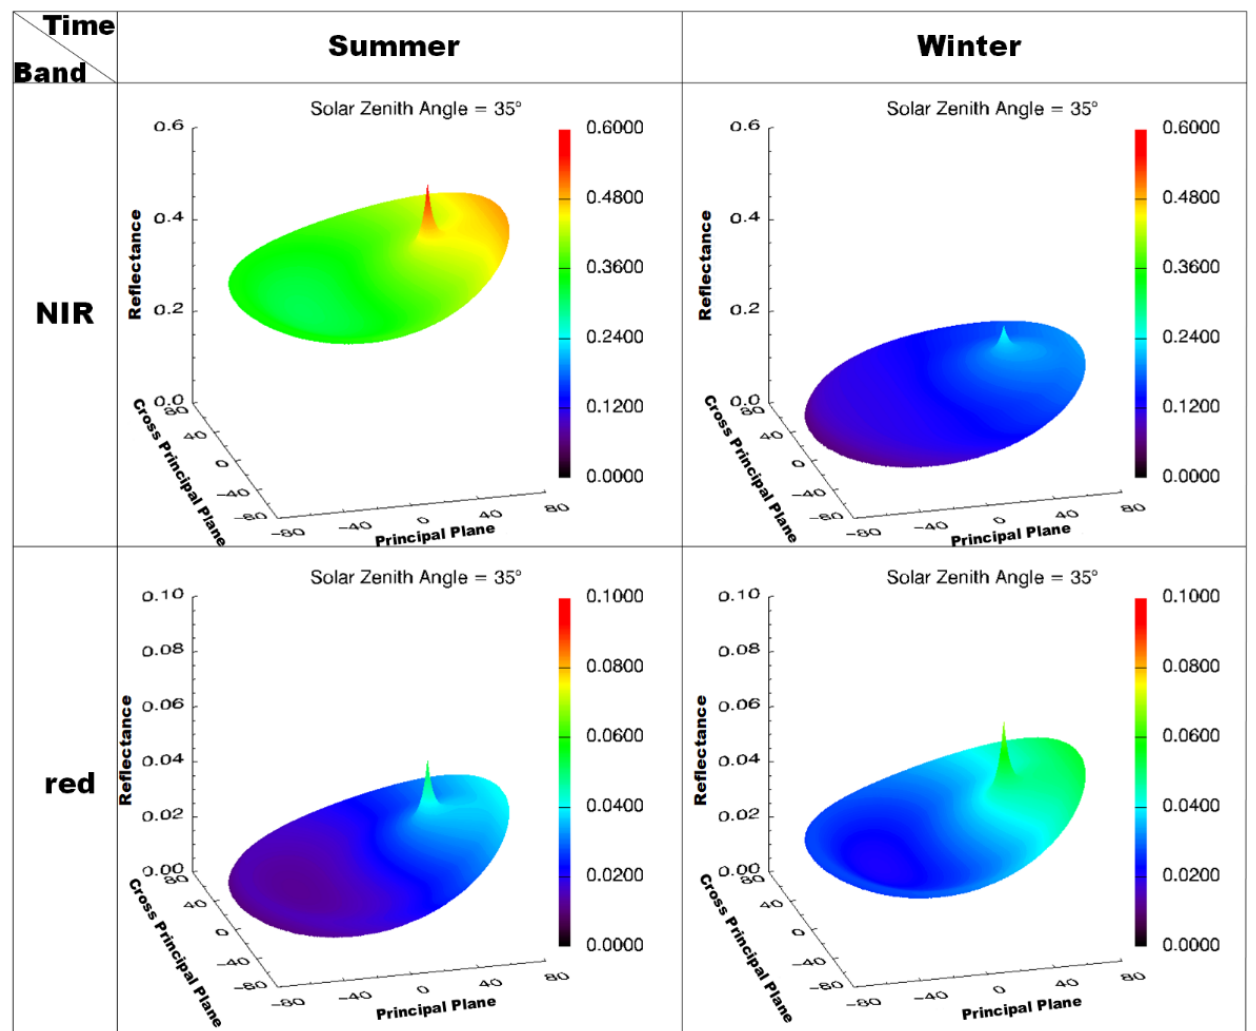
Figure 9. Differences between the BRDFs of red and NIR bands in winter and summer with the forest as the main landcover.